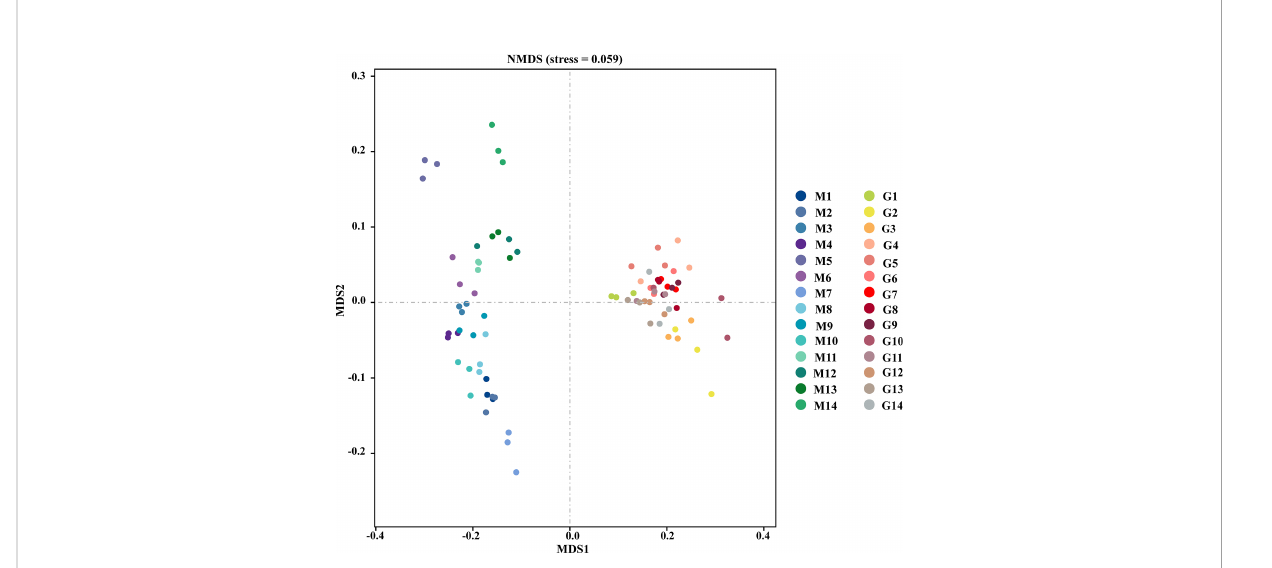
FIGURE 1 Unweighted unifrac nonmetric multidimensional scaling of the bacterial community compositions in the soil between group M and